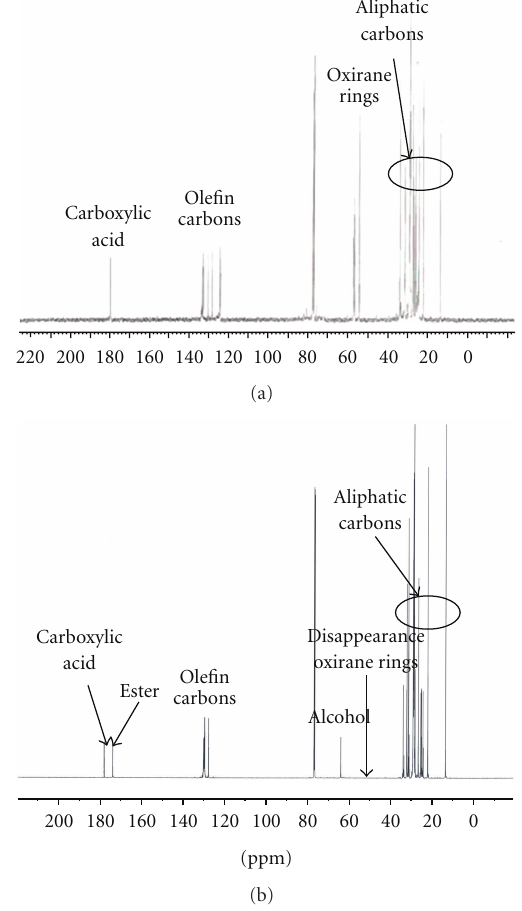
Figure 5: 13 C NMR spectrum of MEOA (a) and HYOOA